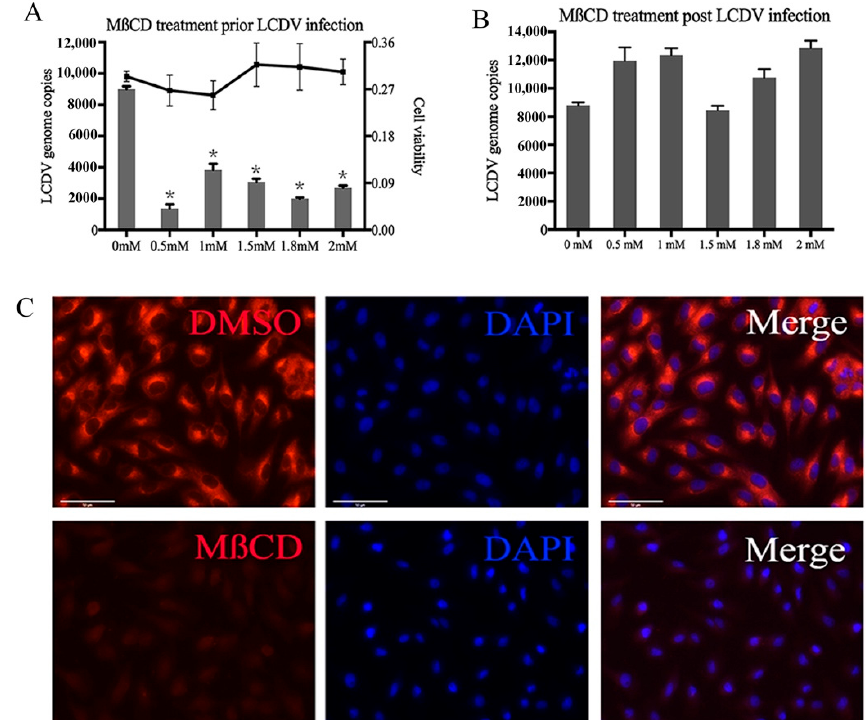
Figure 2. Cholesterol is required for LCDV entry. ( A ) FG cells were pre-incubated with M β CD at 22 °C for 1 h, then incubated with LCDV for another 1 h in the continued presence of reagent. LCDV copy numbers in FG cells were detected by qPCR; the histogram represents virus copy numbers and the line graph represents cell viability. ( B ) FG cells were infected with LCDV for 1 h and then treated with different concentrations of M β CD at 22 °C for 1 h. LCDV copy numbers were detected by qPCR. ( C ) FG cells were treated with 1.5 mM M β CD and then incubated with Alexa fluor 647 conjugated CTB. the fluorescence intensity of CTB in FG cells was observed using fluorescence microscopy; bars = 50 μ m. FG cells treated with DMSO instead of M β CD prior to and post LCDV infection served as negative controls. Error bars ( A , B ) represent standard deviations (SD, n = 3). Asterisks denote significant differences compared with negative controls ( p < 0.05, one- way ANOVA).